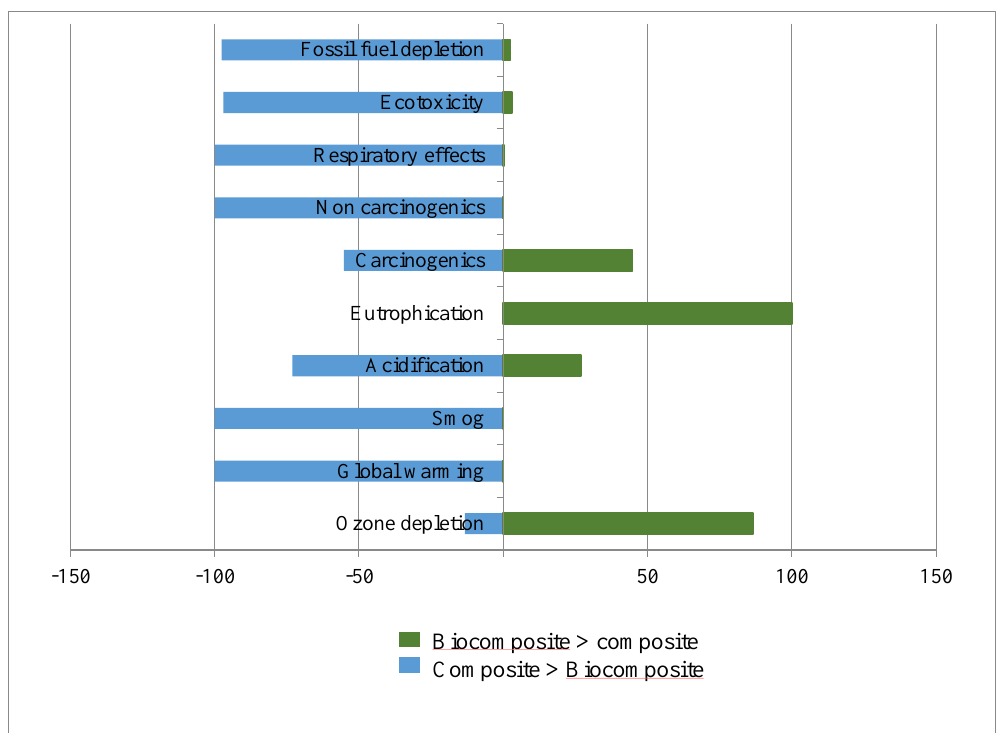
Figure 7. Uncertainty results for comparing biocomposite and petroleum-based composite, with a 95% confidence interval, demonstrating the likelihood of composite or biocomposite having higher or lower impact in each category.